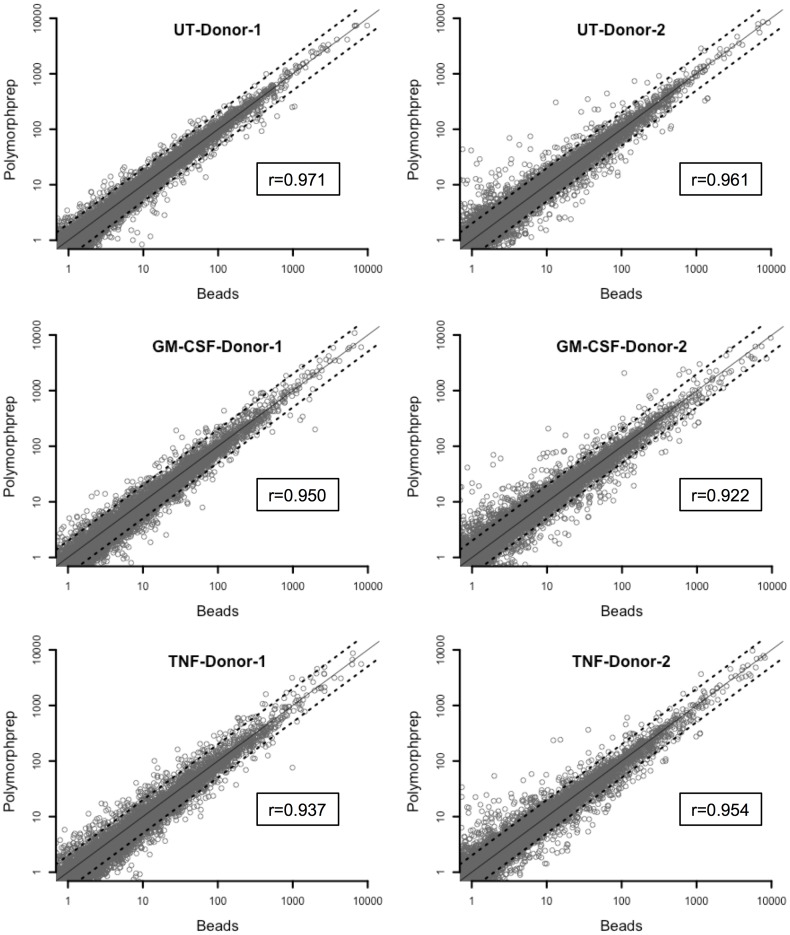
Correlation between transcriptomes of Polymorphprep and negatively-selected neutrophils.Gene expression (RPKM) in neutrophils isolated by Polymorphprep or negative selection (Beads) for Donors 1 and 2 following incubation with or without the addition of GM-CSF (5ng/mL) or TNFα (10ng/mL) for 1h. Pearson Correlation co-efficient is shown (p<0.01). The solid line indicates a correlation coefficient of r = 1.0 and the dashed lines indicate a fold difference in expression of 2.